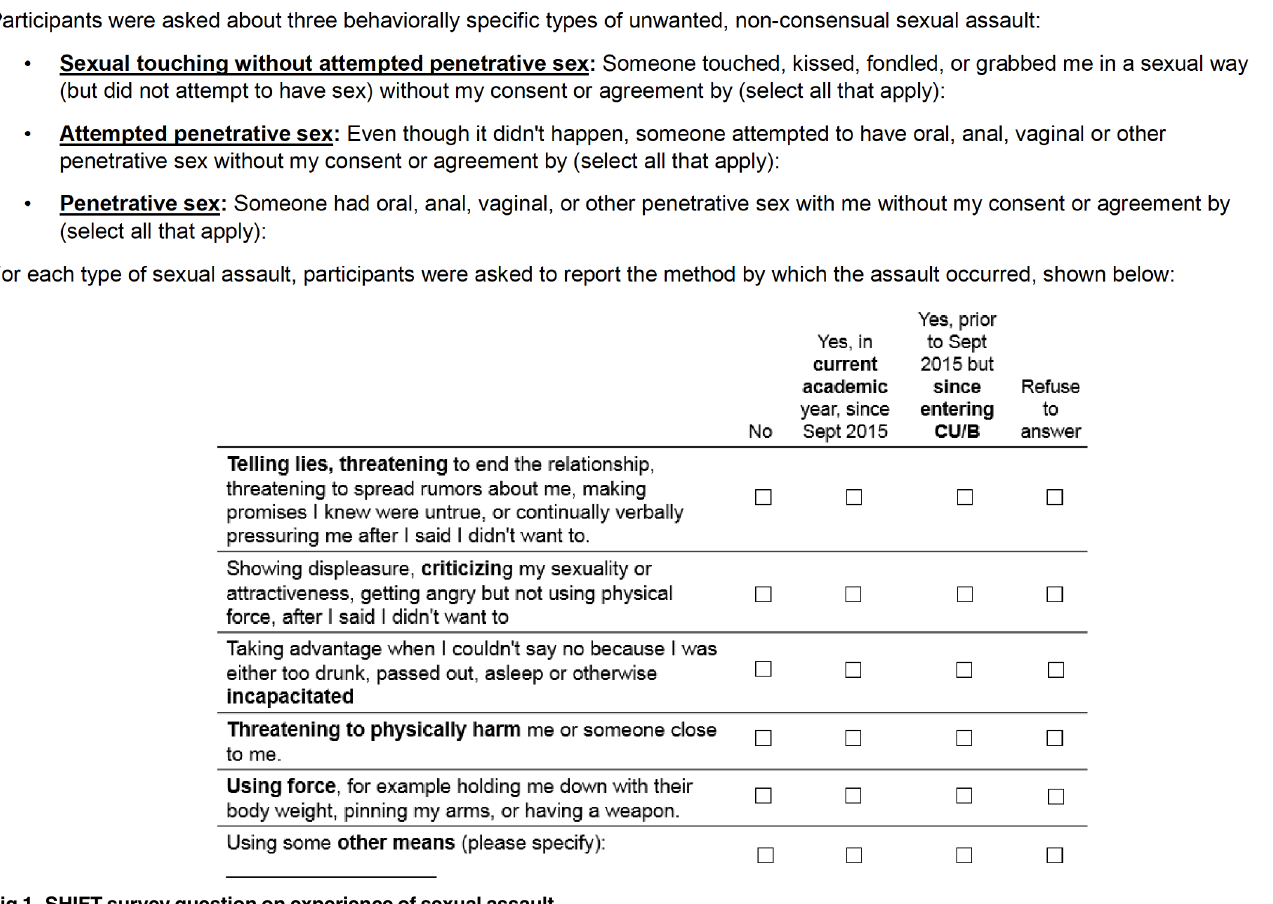
Fig 1. SHIFT survey question on experienceof sexual